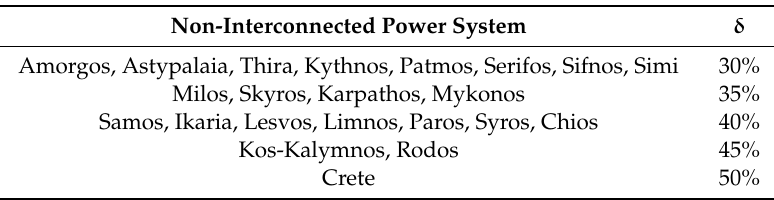
Table 8. Instantaneous wind penetration limit δ .